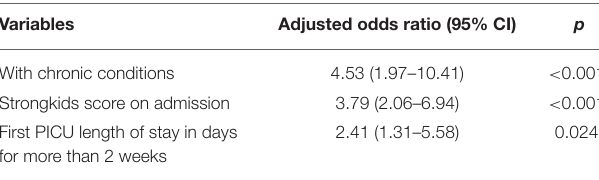
TABLE 6 | Risk factors of PICU late readmission in the multivariate